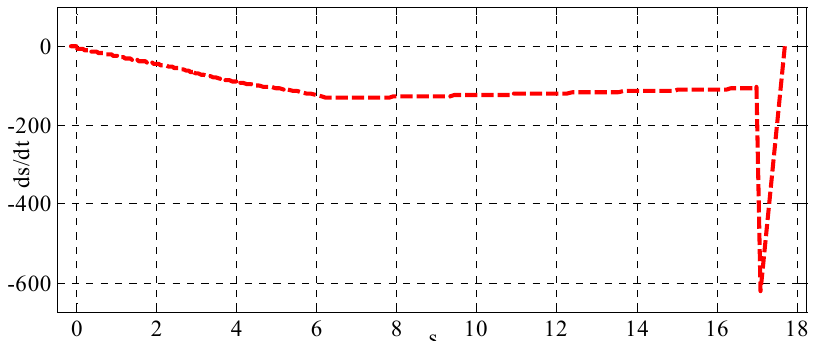
. s (y-axis) versus sliding surface variable s (x-axis) based on Figure 12. Sliding surface derivative Figure 12. Sliding surface derivative 𝑠(cid:4662) (y-axis) versus sliding surface variable 𝑠 (x-axis) based on